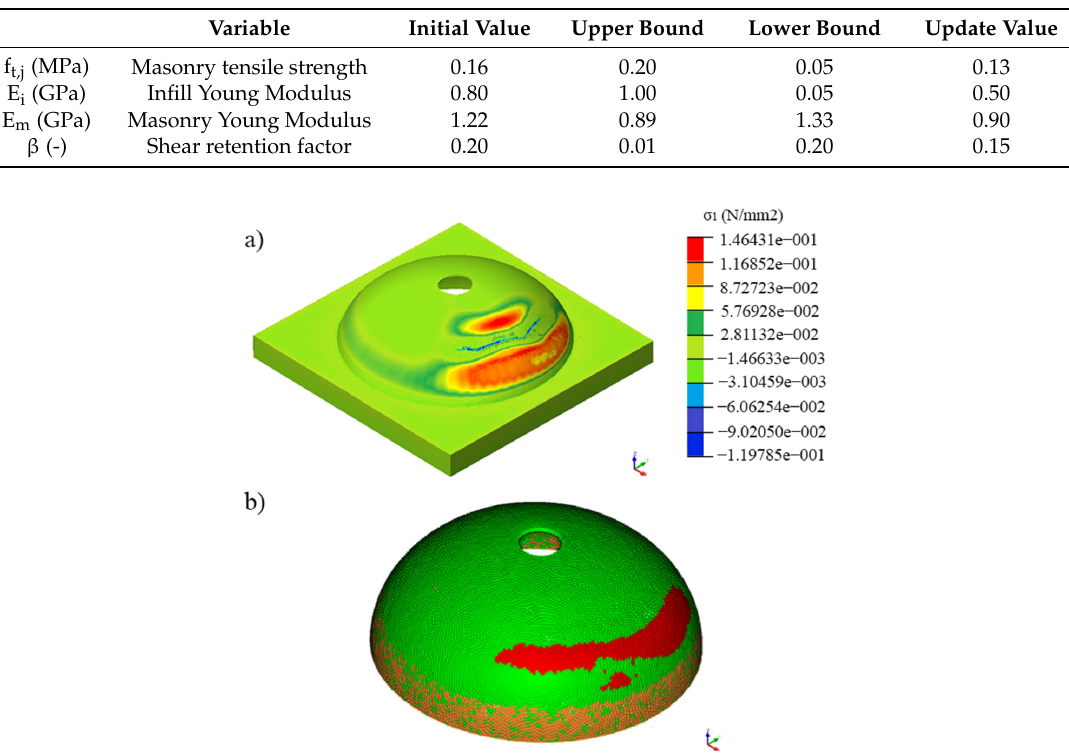
Figure 10. ( a ) First principal stress distribution, expressed in N/mm2 of the updated model; ( b ) Geometrical accuracy, in terms of Local Hausdorff metric ( LHm s ) of the updated model; in green, are carried out and in red, areas where the updated numerical model displays worse